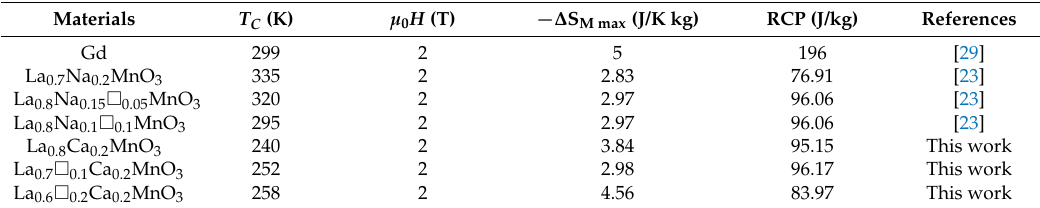
Table 3. Comparison of reported values of the maximum magnetic entropy change ( − ∆ S M max ) and RCP values at the Curie temperature ( T c ) under a magnetic field ( µ 0 H ) for various manganites and the Gd magnetic refrigerant